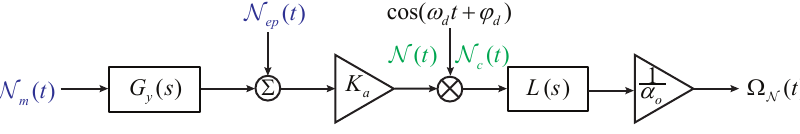
Figure 4. The block diagram of the open-loop noise